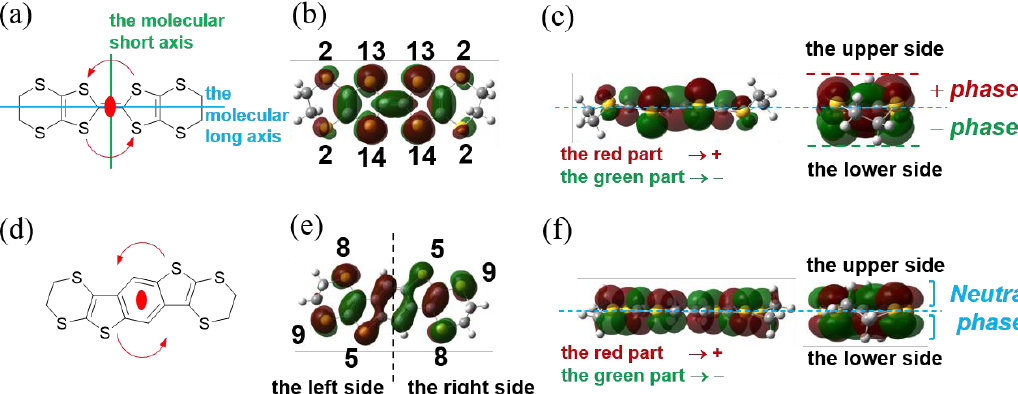
Figure 6. ( a ) Molecular structure and symmetry and ( b , c ) the HOMO distribution and shape of BEDT-TTF. The numbers represent the contributions (%) of the sulfur atoms to HOMO. ( d ) Molecular structure and symmetry and ( e , f ) the HOMO distribution and shape of BEDT-BDT.